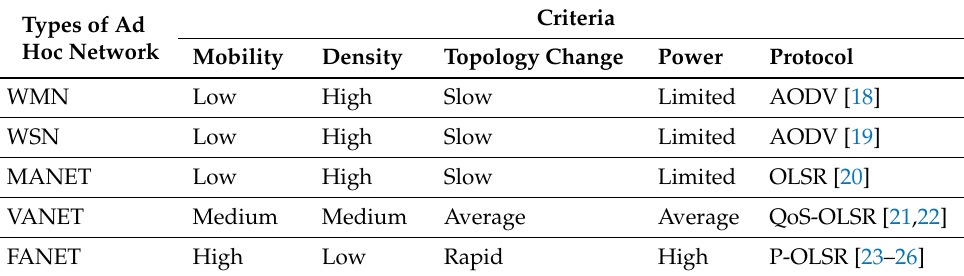
Table 1. comparison table of characteristics of ad hoc network